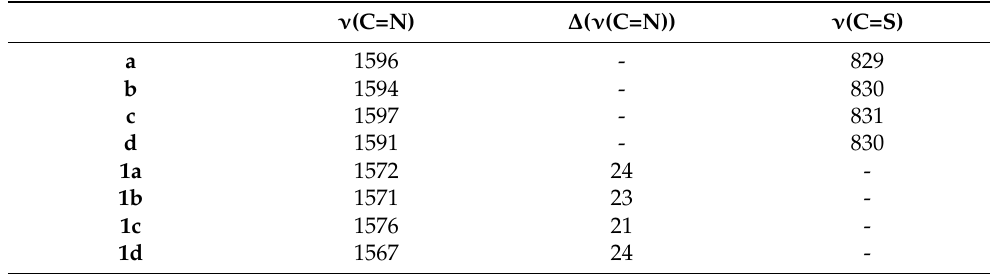
Table 3. Summary of the main bands that experience changes due to the metalation.